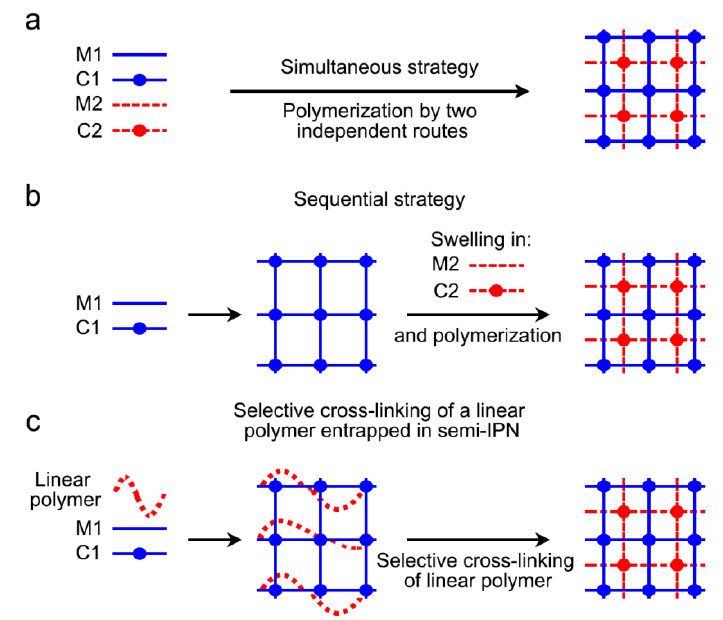
Figure 5. From a synthetic standpoint, interpenetrating polymer networks (IPNs) come in two varieties: (1) sequential IPN, in which one network is swollen with the monomeric composition of the second one, and then the polymerization of the second network is carried out, (2) simultaneous IPN, in which both networks are synthesized at the same time by non-interfering routes. When one of the two copolymers has a linear structure instead of a cross-linked one, a semi-IPN is obtained. Adapted from Dragan (2014) [91] [( a ) simultaneous strategy; ( b ) sequential strategy; ( c ) selective cross-linking of a linear polymer entrapped in a semi-IPN].